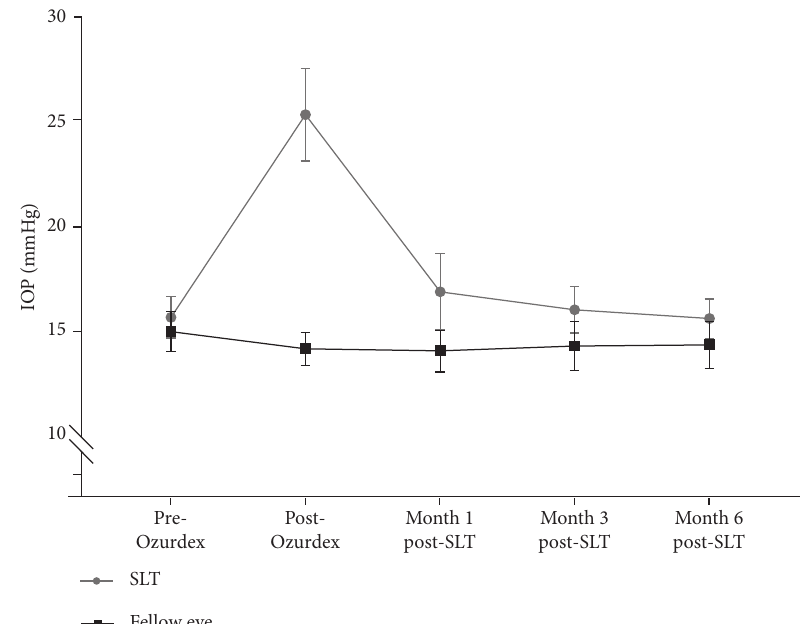
Figure 2: Evolution of mean intraocular pressure (IOP) before and after a DEX-implant injection in eyes that underwent selective laser trabeculoplasty versus contralateral eyes at one, three, and six months after